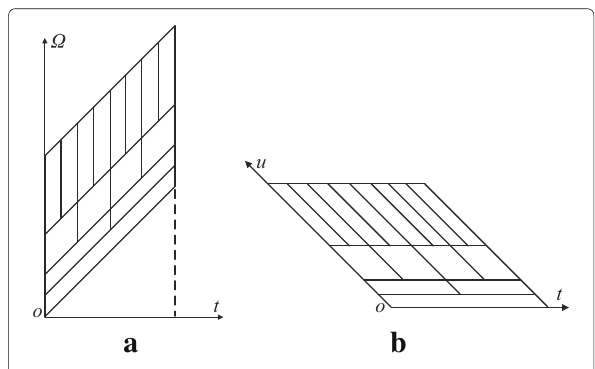
Fig. 3 a The time-frequency plane divided by time-frequency cells. b The time-LCD-frequency plane divided by time-LCD-frequency